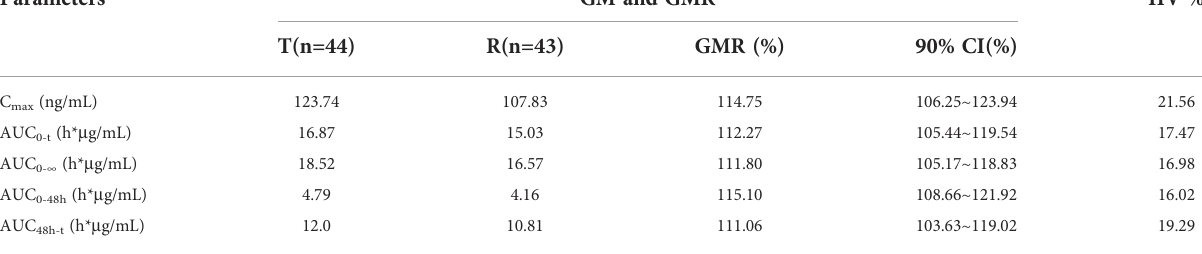
TABLE 5 The Bioequivalence Analysis of Free Doxorubicin. Parameters